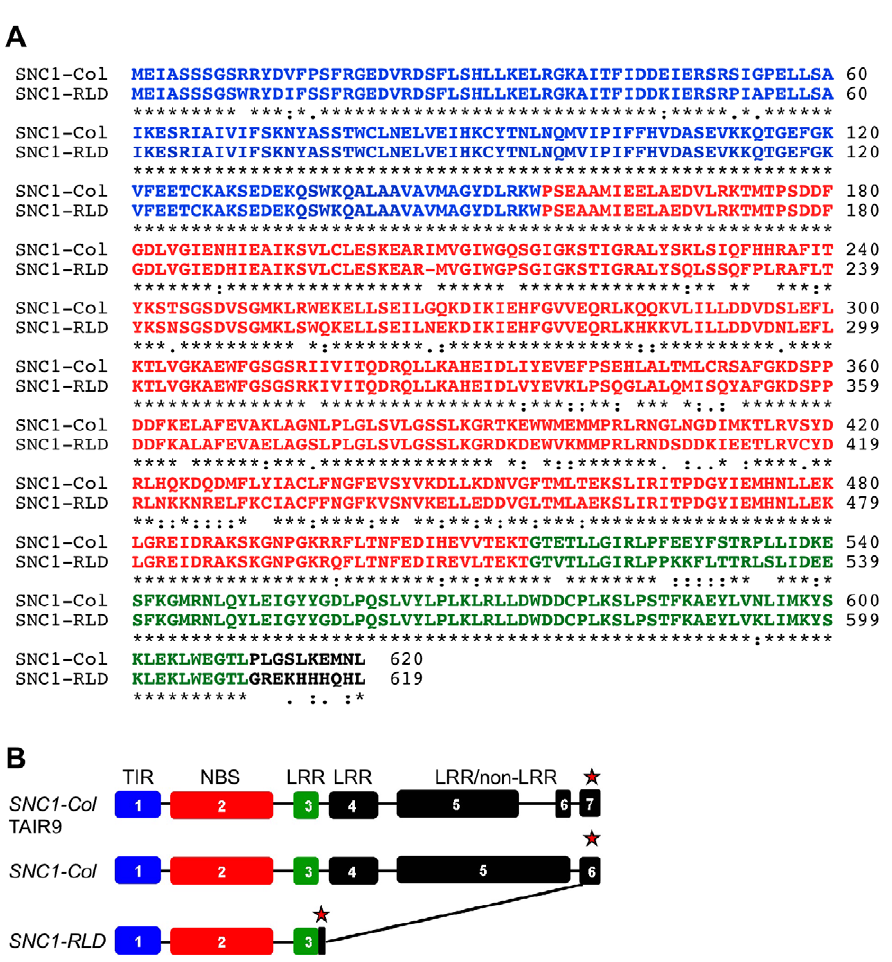
Figure 4. SNC1-RLD encodes a truncated TNL protein. (A) Alignment of deduced amino acid sequences of SNC1-Col (top) and SNC1-RLD (bottom) using the EBI-ClustalW tool (http://www.ebi.ac.uk/Tools/clustalw/) [54]. Identical amino acids are indicated by asterisks. Colons and semi- colons show conserved substitutions and semi-conserved substitutions, respectively. Characters in blue, red and green show the amino acids corresponding to exon 1, exon 2 and exon 3, respectively. (B) SNC1 gene model as experimentally verified by reverse transcription PCR and 3 9 -RACE from Col-0 (middle) and RLD (bottom) compared with the TAIR9 gene model (top). Exons are indicated by boxes, introns by lines, and stop codons by red